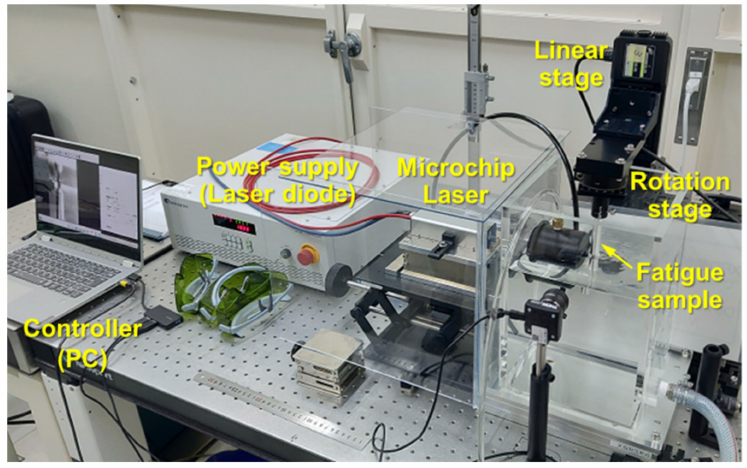
Figure 3. The LPwC setup for rod samples used for rotation-bending fatigue